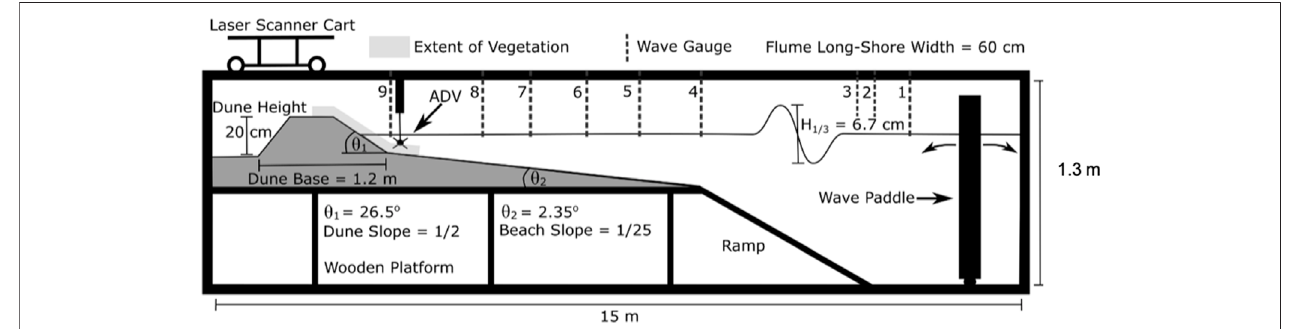
FIGURE 2 | Schematic of sediment wave fl ume setup including the area of vegetation plantings.